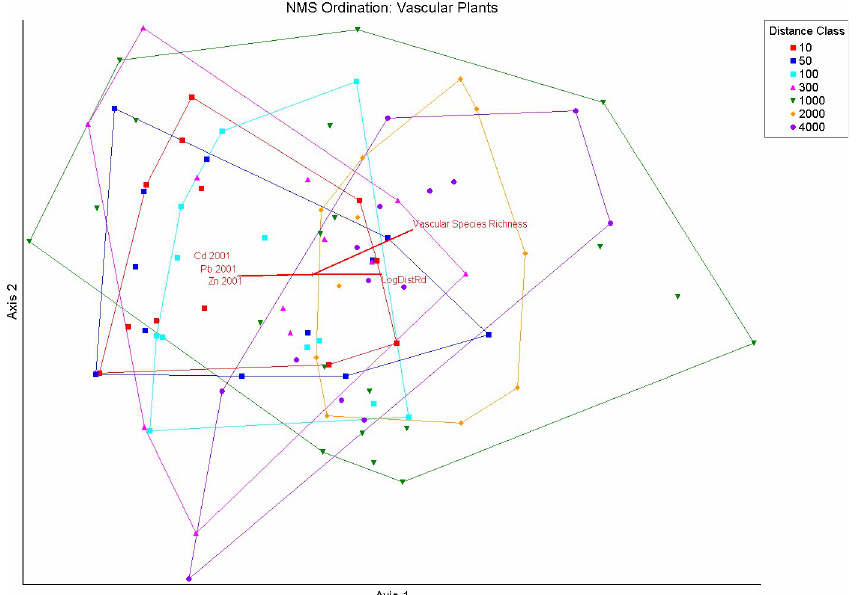
Fig 8. Nonmetric multidimensional scaling ordination of vascular plants in a matrix of 93 plots x 36 species along the DMTS haul road in Cape Krusenstern National Monument, Alaska. The ordination is overlain by vectors proportional to the strength of their correlation with ordination axes. Convex hulls surround plots in each distance class. Variables with Spearman correlations r > 0.4 are presented: LogDist_Rd (log 10 distance to the road), Vascular Species Richness (VPSR), and modeled Cd, Pb and Zn from 2001